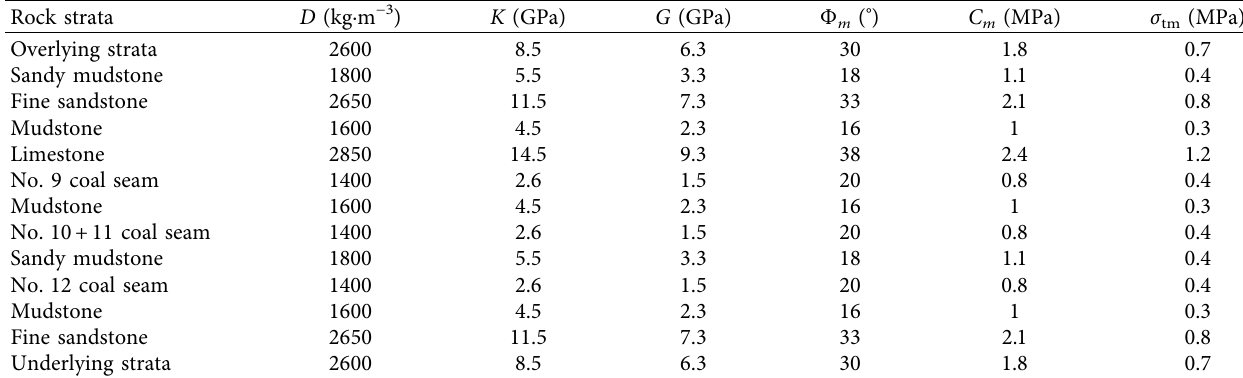
Figure 8: Numerical simulation model of mining under double gobs in close coal seams. Table 1: Rock strata properties used in the numerical